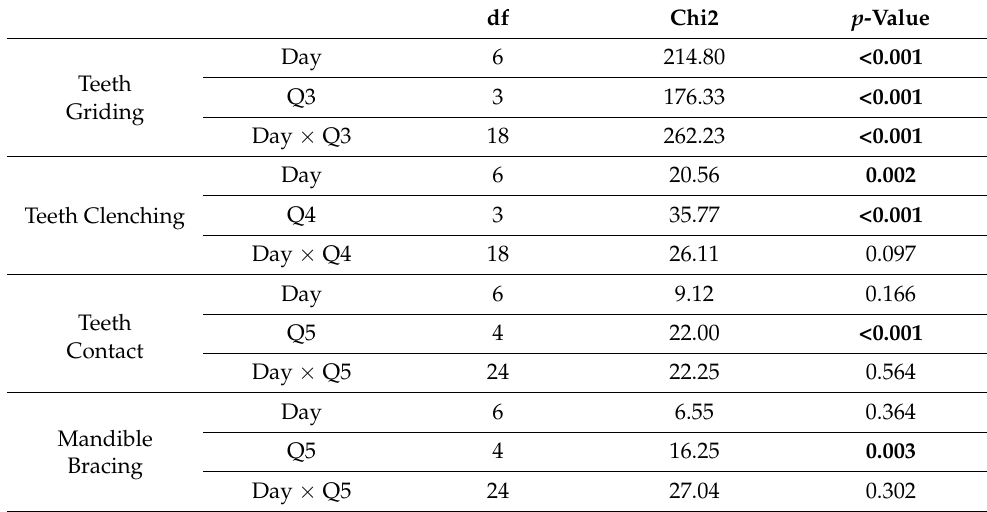
Table 5. Results of the General Linear Mixed Model (GLMM) for repeated measurements assessing the association of the reported frequency of each Oral Behaviour (OB) activity recorded with the smartphone-based application for Ecological Momentary Assessment (EMA) on different days, with the specific Oral Behaviours Checklist (OBC) test scores. Statistically significant differences are reported in bold.